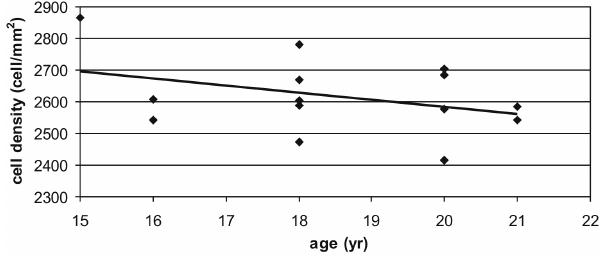
Fig. 5. The correlation between age and cell density in the two groups, inverse proportion ( r ¼ (cid:1) 0 : 43; p ¼ 0 : 094).